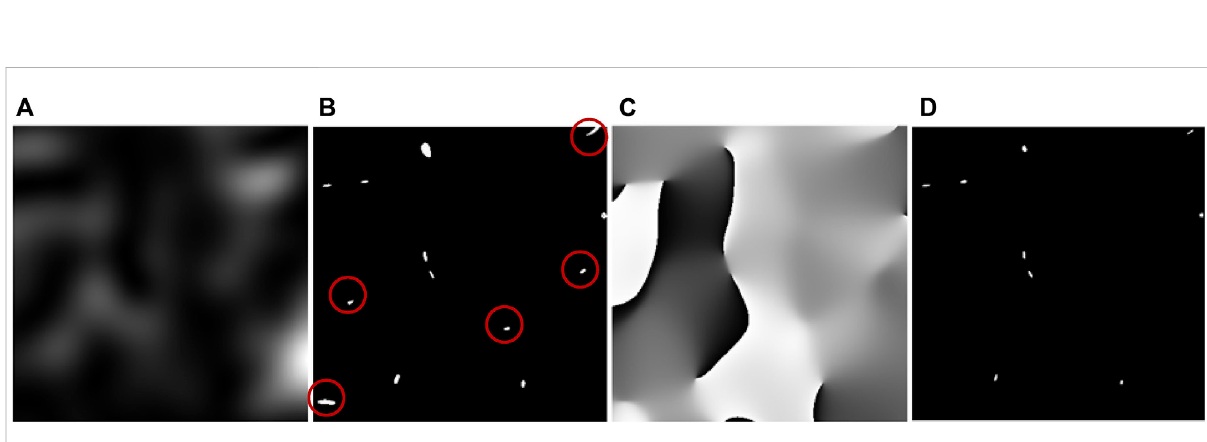
FIGURE 12 Localization of the amplitude zeros in the fi eld scattered by a rough surface: (A) intensity distribution I ( r ) ; (B) preliminary locations of the intensity minima(shownby bright spots); (C) phase distribution; (D) locations of theamplitude zeros. Red contours in (B) indicate “ false ” zeros which are fi ltered out due to the correlation-length